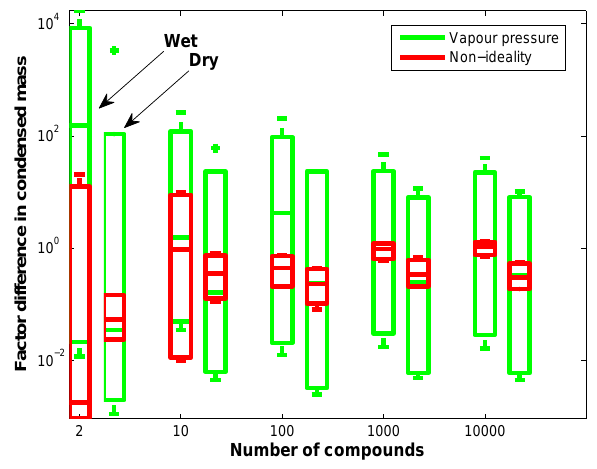
Fig. 3. An example illustration of the sensitivity of predicted to- tal condensed organic mass across all conditions to the differences in vapour pressure predictive technique in the partitioning model (green bars, n =45) and the inclusion of non-ideality (red bars, n =9). The left-hand bar in each pair encompasses all property pre- diction variants, all T- and